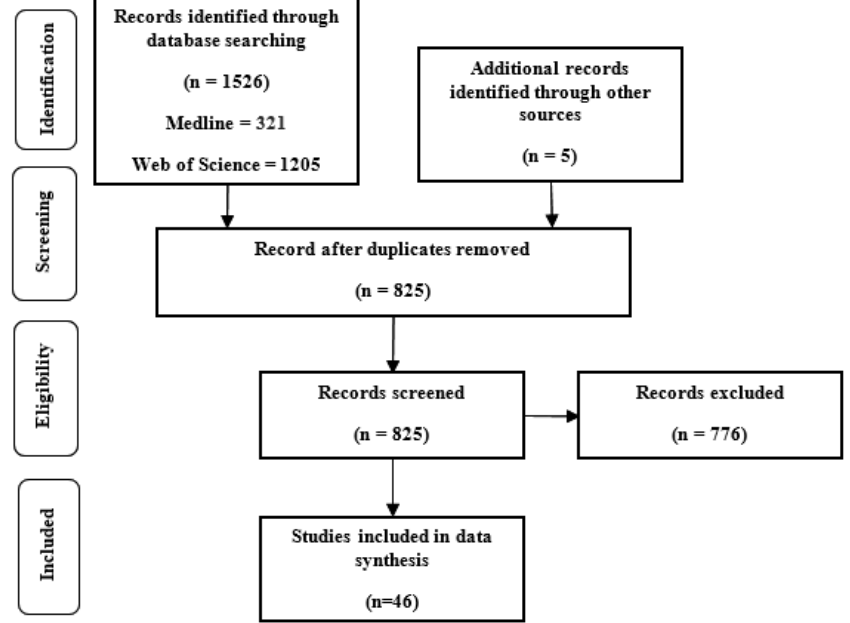
Figure 1. Included research flow diagram based on PRISMA guideline [21].